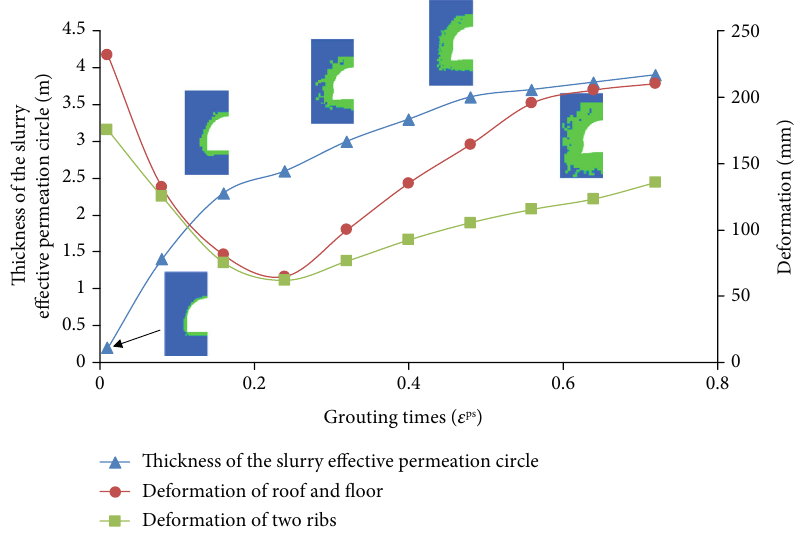
Figure 4: The thickness of the slurry e ff ective permeation circle and the deformation of the roadway surrounding rock at various grouting timings.